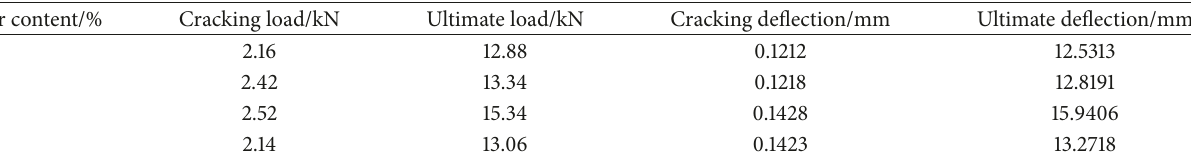
Table 7: Simulation of the four-point bending bearing capacity parameters.